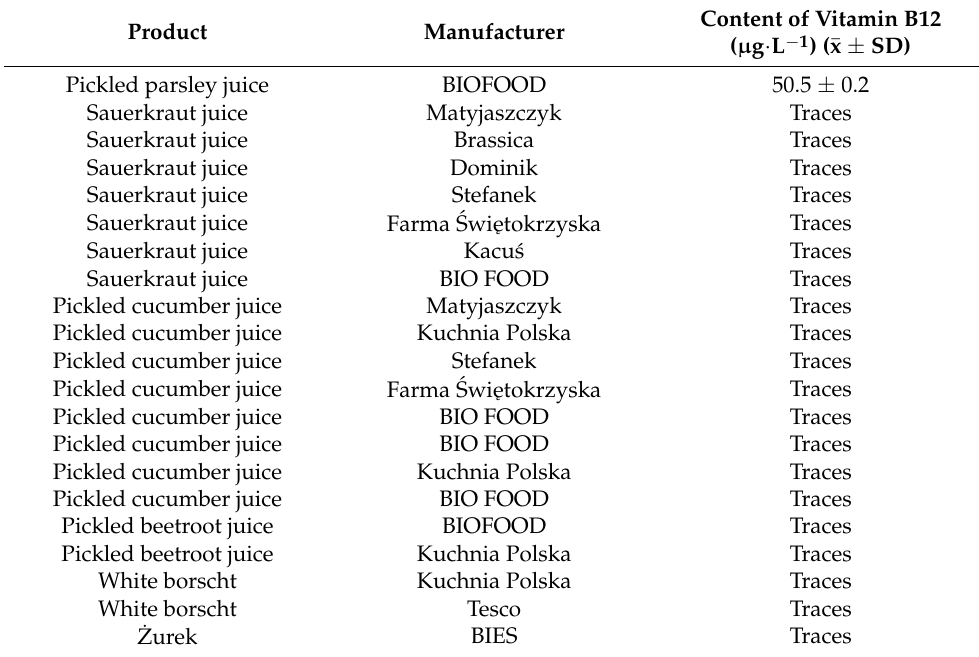
Table 2. Content of cyanocobalamin in liquid samples of fermented vegetable products.